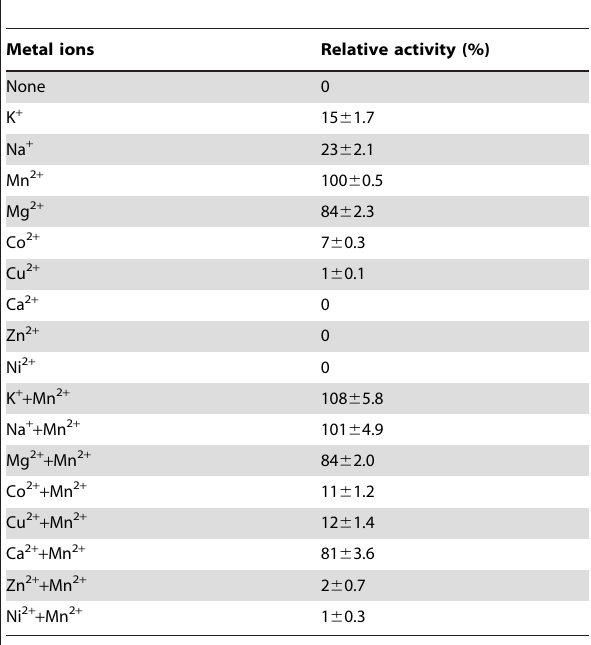
Table 2. Effects of metal ions on the activity of recombinant SmIDH a .